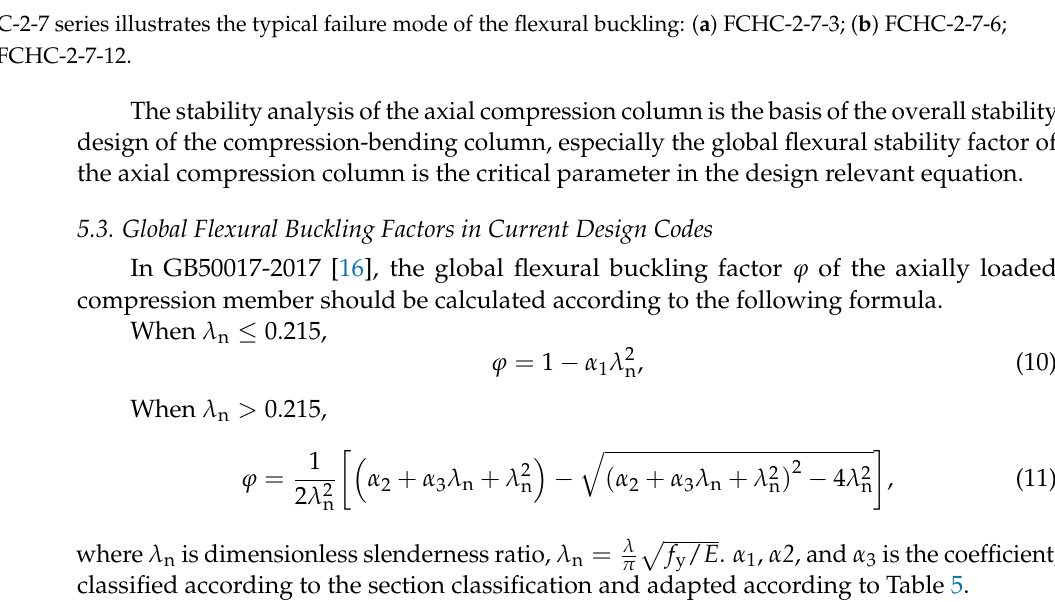
( d ) Figure 8. The FCHC-1-7 series illustrates the typical failure mode of the flexural-torsional buckling: ( a ) FCHC-1-7-3; ( b ) FCHC-1-7-6; ( c ) FCHC-1-7-9; ( d ) FCHC-1-7-12.